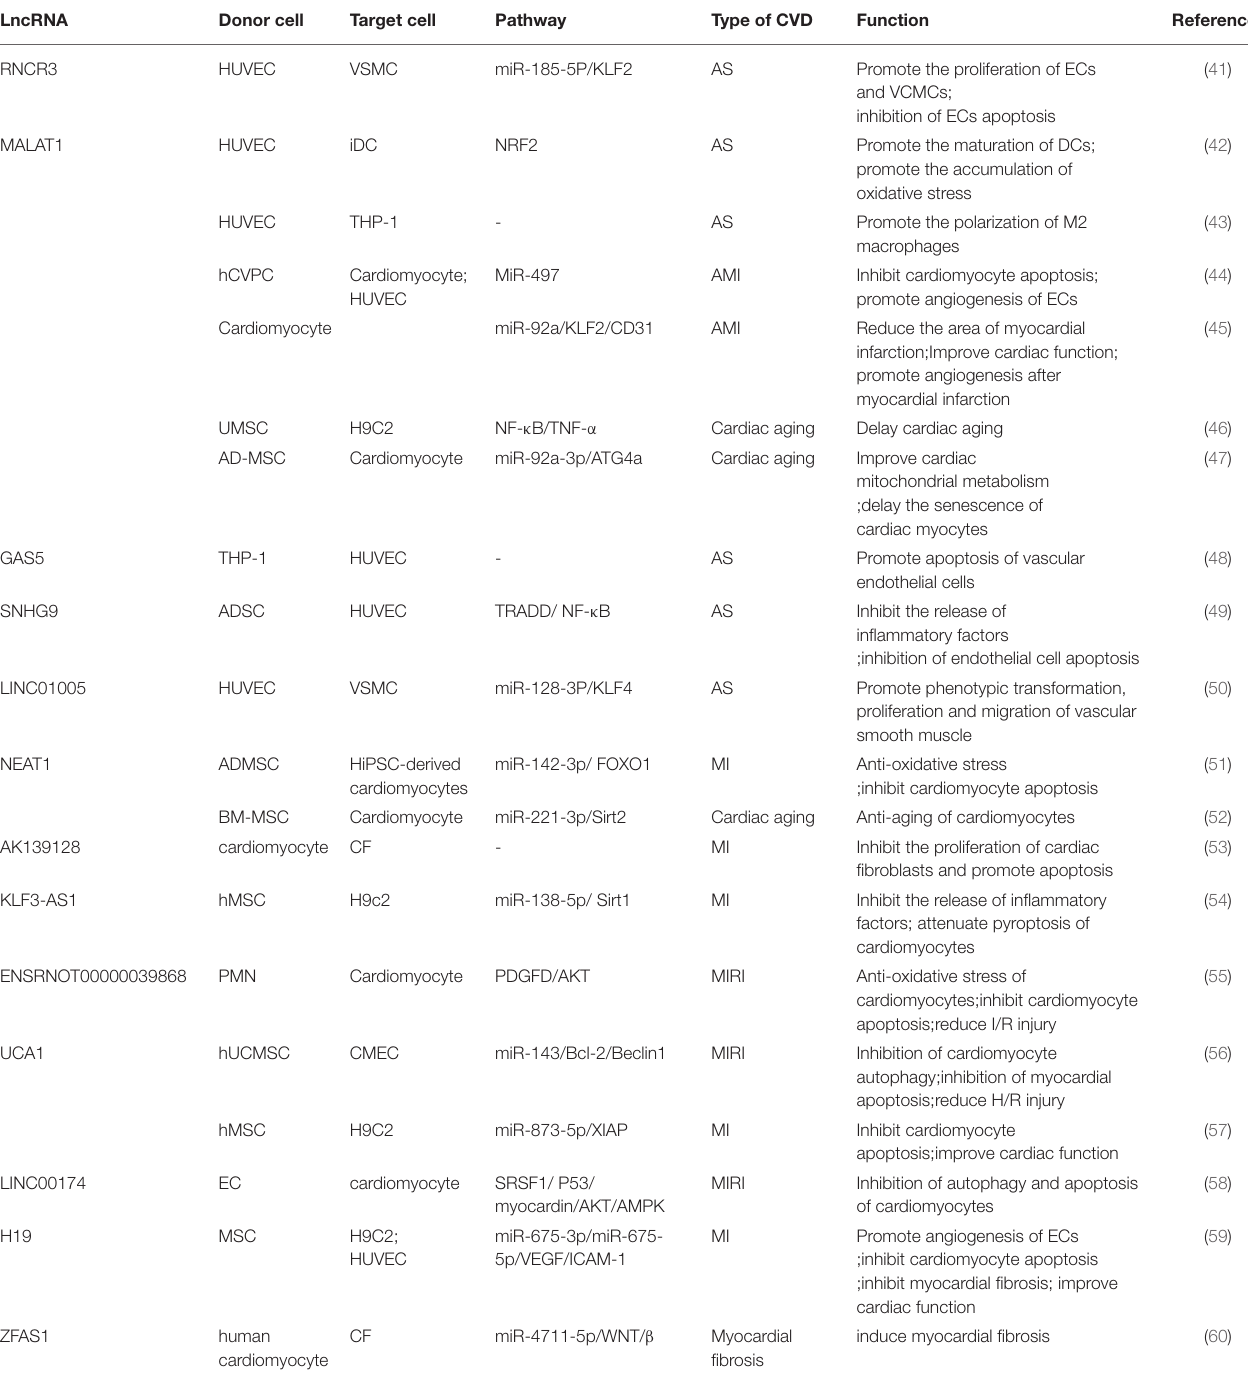
TABLE 1 | Progress of exosomal lncRNA in preclinical study of CVD.